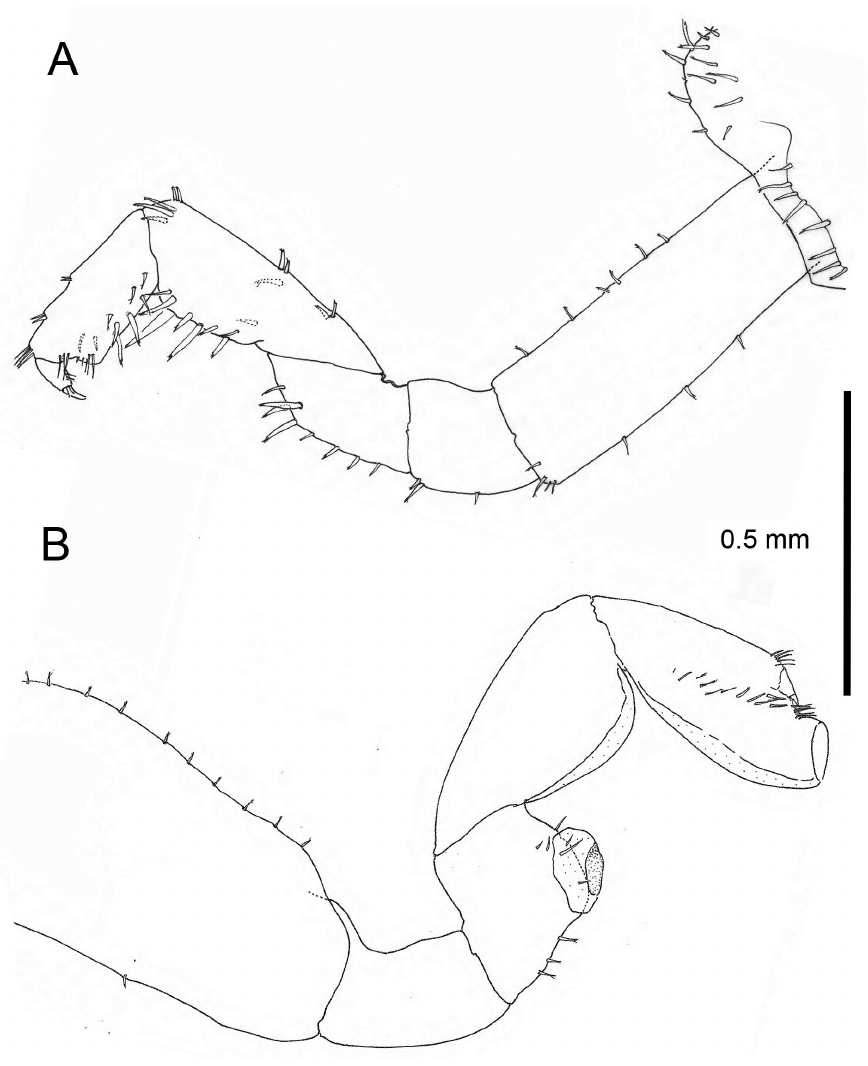
Figure 8. Cryptorchestia ruffoi sp. n., paratype female 10.8 mm (RMNH) A gnathopod 1 B gnathopod 2.